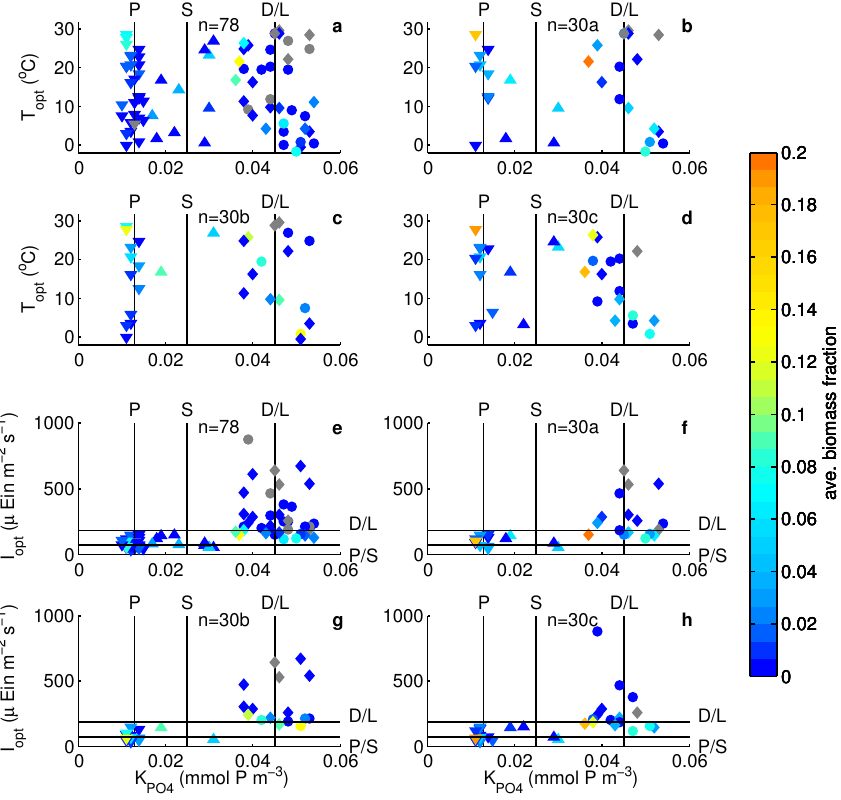
Figure 4. Position of individual phytoplankton subtypes in the trait space given by optimum temperature ( T opt ; a–d ) and optimum light intensity ( I opt ; e–h ) vs. half-saturation concentration for phosphate uptake ( K PO ) for the simulation with n = 78 types (a, e) and the three simulations with n = 30 types (b–d, f–h) . Downward and upward pointing triangles identify Prochlorococcus and other small subtypes, respectively. Circles and diamonds identify diatoms and other large subtypes, respectively. Colour shading indicates the global average fraction of total biomass for each subtype. Grey symbols indicate subtypes with 0 biomass fraction in the global average. Vertical and horizontal lines indicate K PO and I opt , respectively, of the PFTs in the n = 4 and n = 3 simulations, i.e. Prochlorococcus (P) analogues, other small phytoplankton (S), other large phytoplankton (L), and diatom analogues (D).